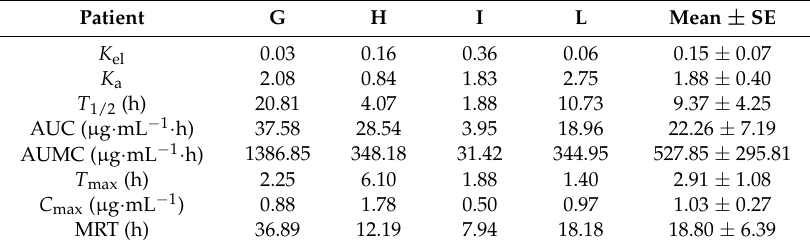
Table 3. Pharmacokinetic parameter estimates of melatonin in Group-2.